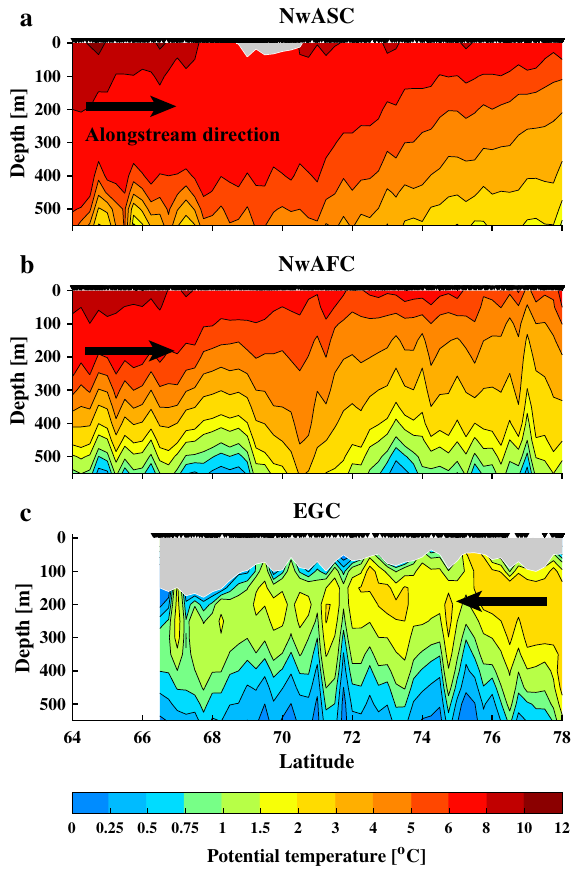
Fig. 2 | Along-pathway transformation of Atlantic Water. Vertical sections of temperature for the Atlantic Water layer (upper 550m) along the three boundary currents: the ( a ) Norwegian Atlantic Slope Current (NwASC), b Norwegian Atlantic Front Current (NwAFC), and c East Greenland Current (EGC). The black arrow indicates the alongstream direction. The Polar Surface Water layer (de fi ned by salinity <34.5 and potential density <27.7kgm − 3 ) is masked by gray shading. The